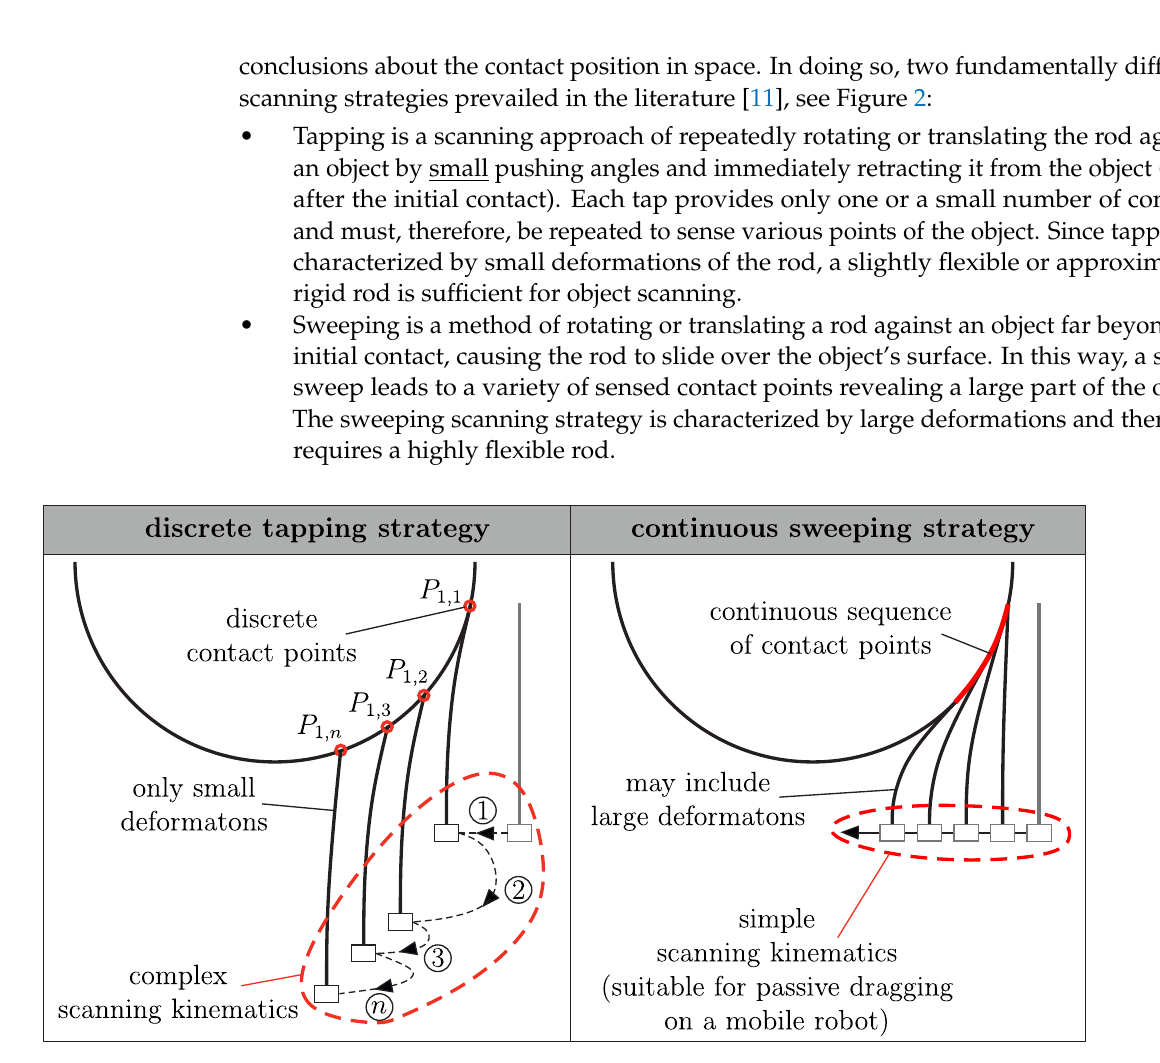
Figure 2. Comparison of two different object scanning